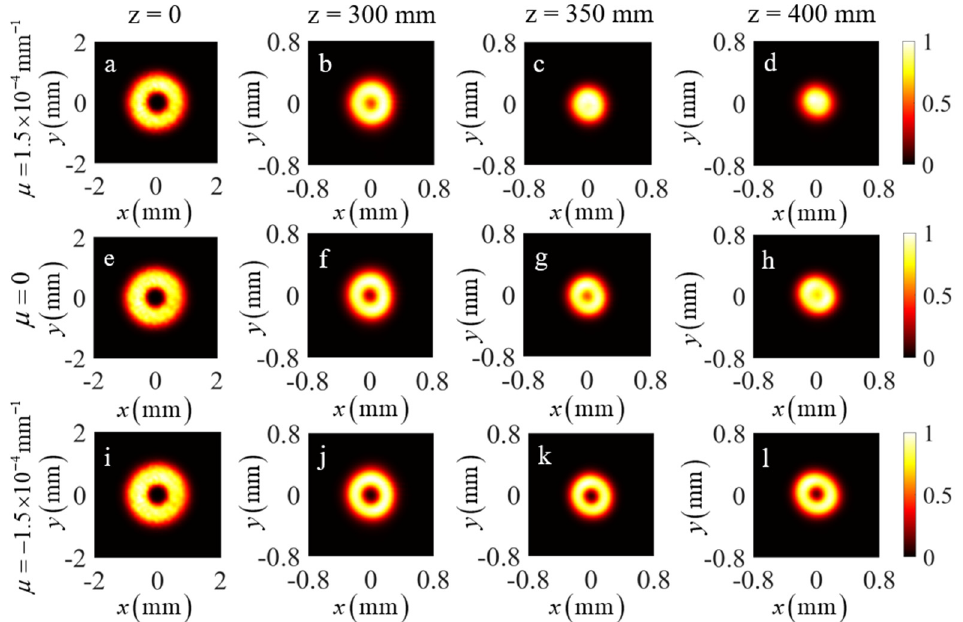
Figure 9. The experimental results for the averaged intensity at different propagation distances of the generated TLGSM beam with ( a – d ) the twist factor 𝜇 = 1.5 × 10 (cid:2879)(cid:2872) mm (cid:2879)(cid:2869) , ( e – h ) 𝜇 = 0 , and ( i – l ) the generated TLGSM beam with ( a – d ) the twist factor µ = 1.5 × 10 − 4 mm − 1 , ( e – h ) µ = 0, and 𝜇 = −1.5 × 10 (cid:2879)(cid:2872) mm (cid:2879)(cid:2869) . ( i – l ) µ = − 1.5 × 10 − 4 mm − 1 .